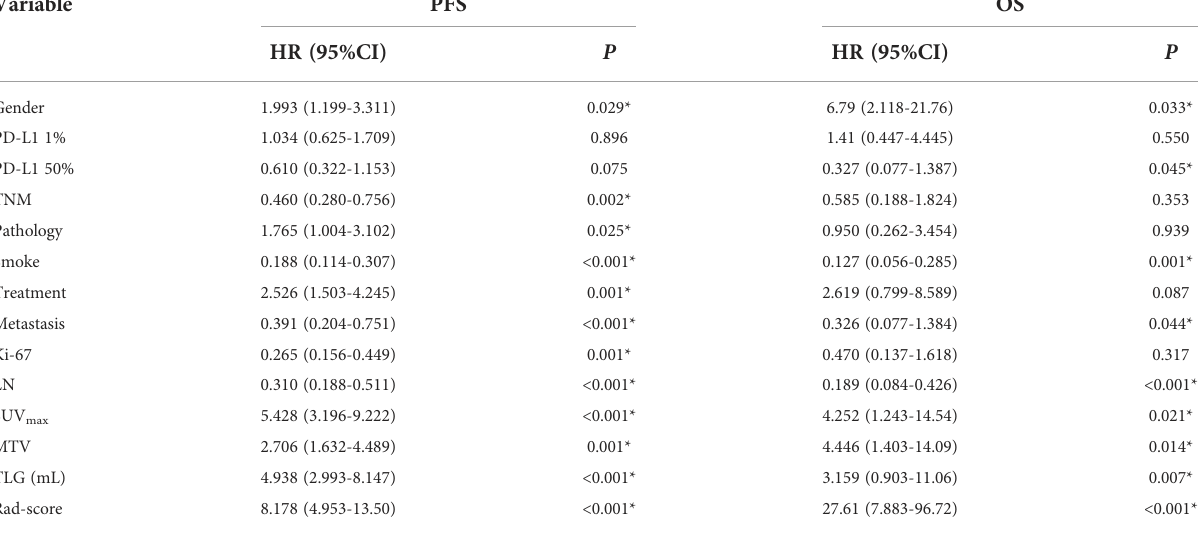
TABLE 2 The results of the univariate Cox regression